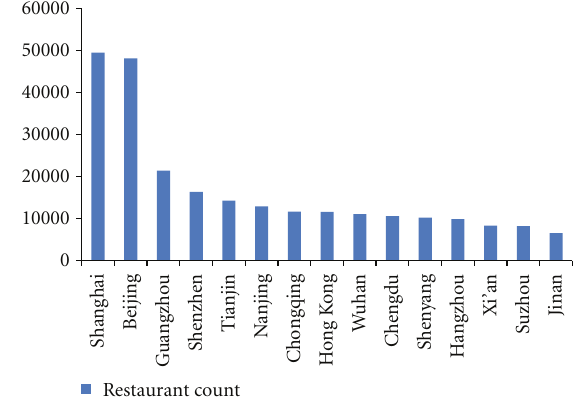
Figure 5: Top 15 cities according to restaurant